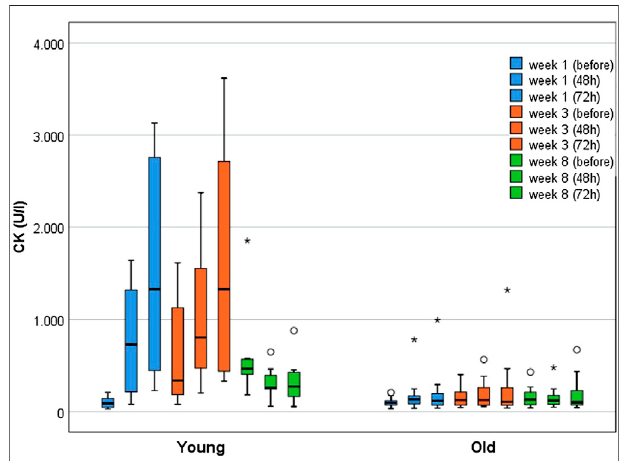
FIGURE 3 | Boxplots displaying the median with interquartile range for CK kineticsofyoung( n =10) and older participants ( n =18) over thecourse of 8 weeks (immediately before, after 48 h, after 72 h) WB-EMS. Starting from week 5, three WB-EMS sessions were performed within 2 weeks with breaks of 4 days. Therefore, CK elevations before the last training in week 8 represent the 96 h CK peak of the previous WB-EMS